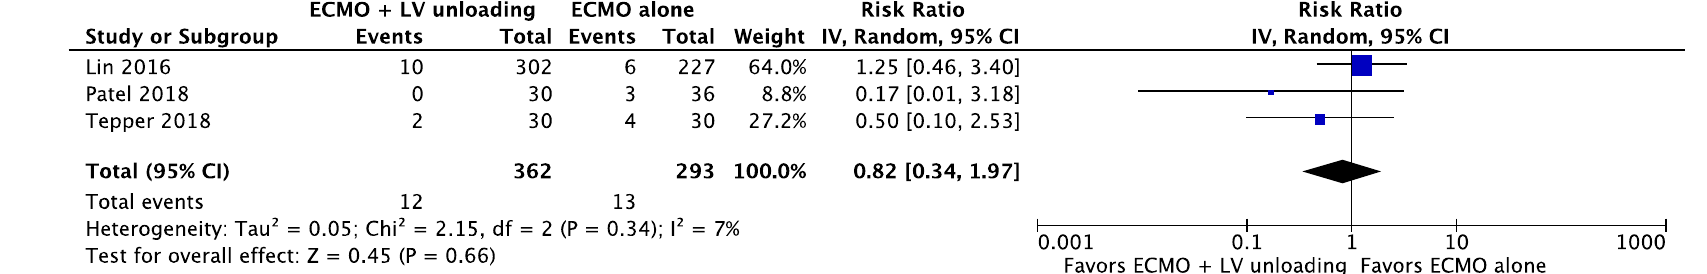
Figure A6. Neurologic complications.